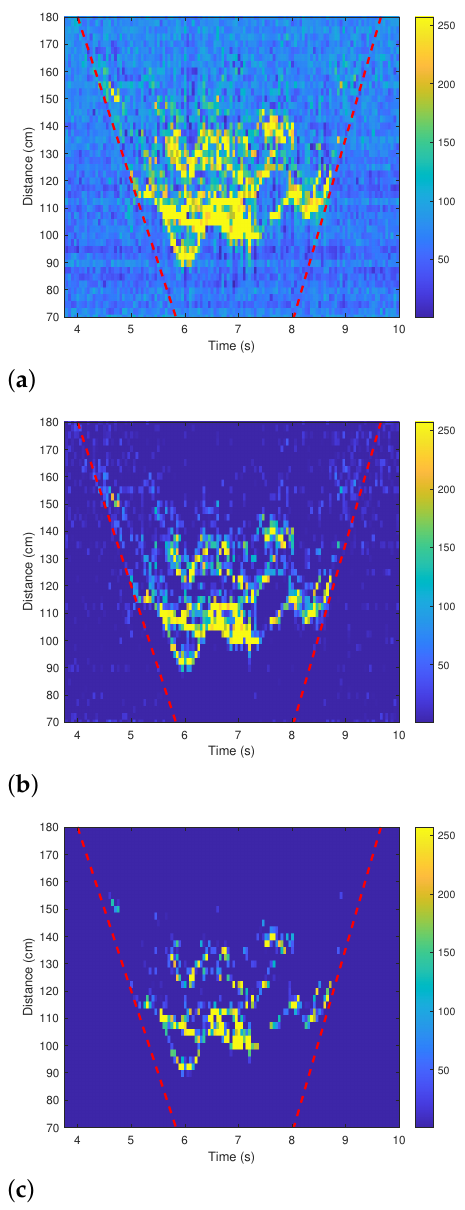
Figure 5. Spectrograms: ( a ) Before applying the mean subtraction method ( X ( N p ) ). ( b ) After removing the DC component ( Y ( N p ) ). ( c ) After removing the DC component and the static clutter ( Z ( N p )